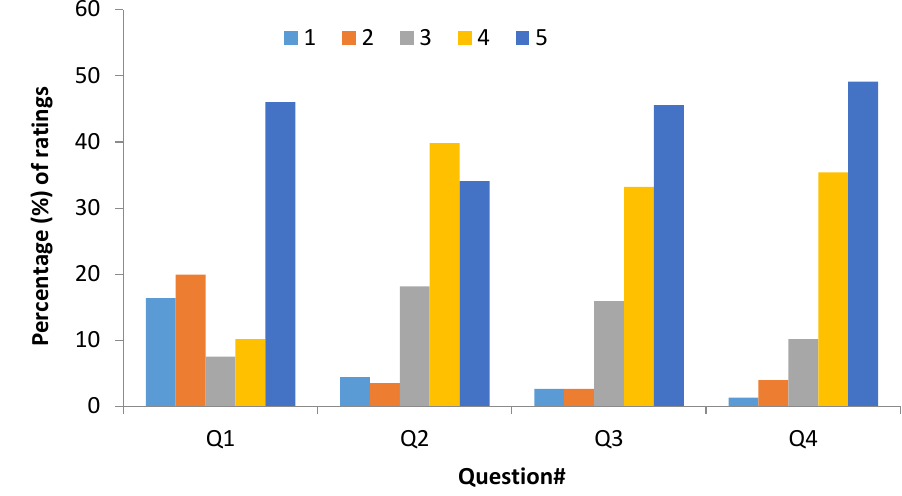
Figure 3. Ratings for level 1 questions.